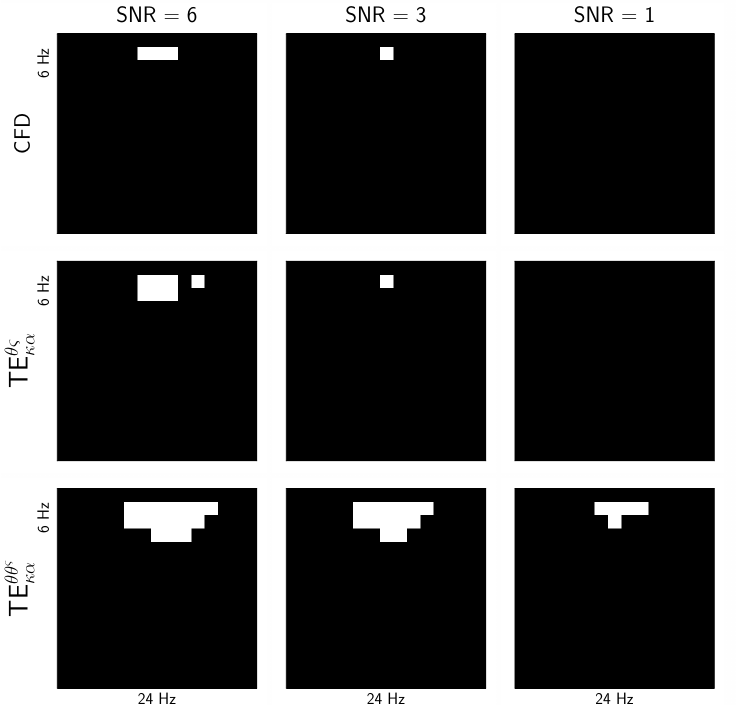
Figure 5. Results of the permutation tests carried out on the connectivity values estimated using CFD, TE θς κα and TE θθς κα , for the three noise conditions modeled (SNR = [ 6,3,1 ] ), assuming interactions in the simulated data from the phase of x w η to the amplitude of y w η . Statistically significant results are shown in